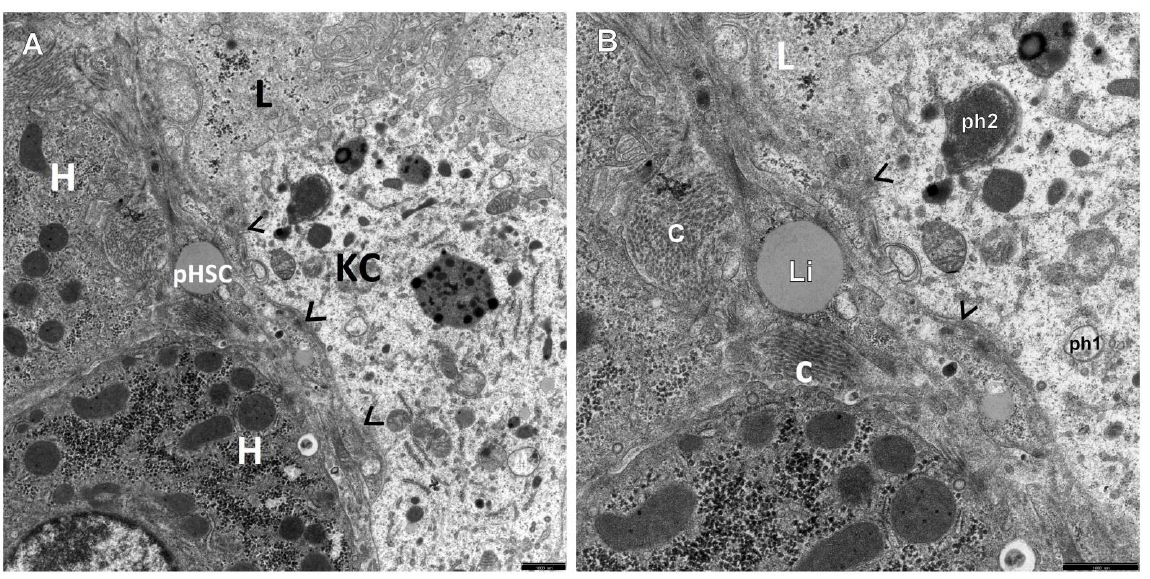
Figure 2. ( A , B ) A picture of a markedly elongated perisinusoidal pHSC adhering to the smoothed vascular pole of the hepatocyte (H). The T-HSC has very thin cytoplasmic processes and contains a single lipid droplet (Li) and dilated ger components. An activated and markedly swollen Kupffer cell (KC), containing primary (ph1) and secondary (ph2) phagosomes, adheres directly to the pHSC from the side of the sinusoidal vascular lumen (L). Between the smoothed vascular pole of the hepatocytes directed towards the perisinusoidal space and the pHSC, there are tiny bundles of mature collagen fibers (c). Larger magnification demonstrates tight intercellular junctions between pHSC and KC (>). Scale bar: 1 μm , original magnifications: ×7000 ( A ), ×12,000 ( B ).